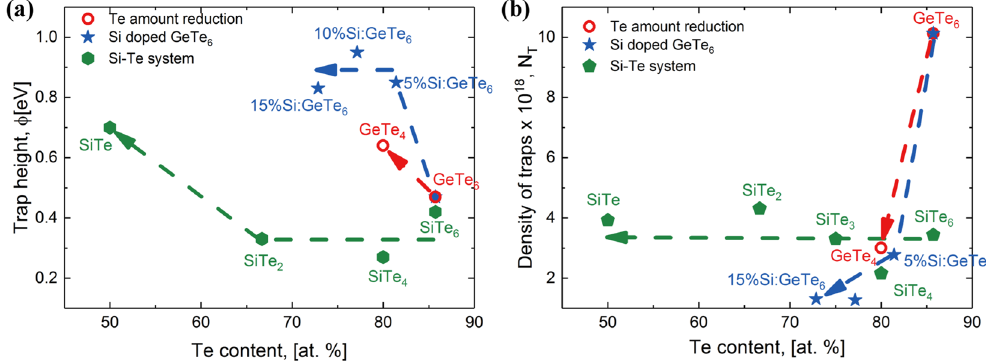
Figure 5. Subthreshold conduction parameters in Ge-Te and Si-Te systems. ( a ): Variation of trap depth extracted using the Poole-Frenkel equation for all the studied materials ( b ): Density of defects as a function of Te amount derived from Poole-Frenkel